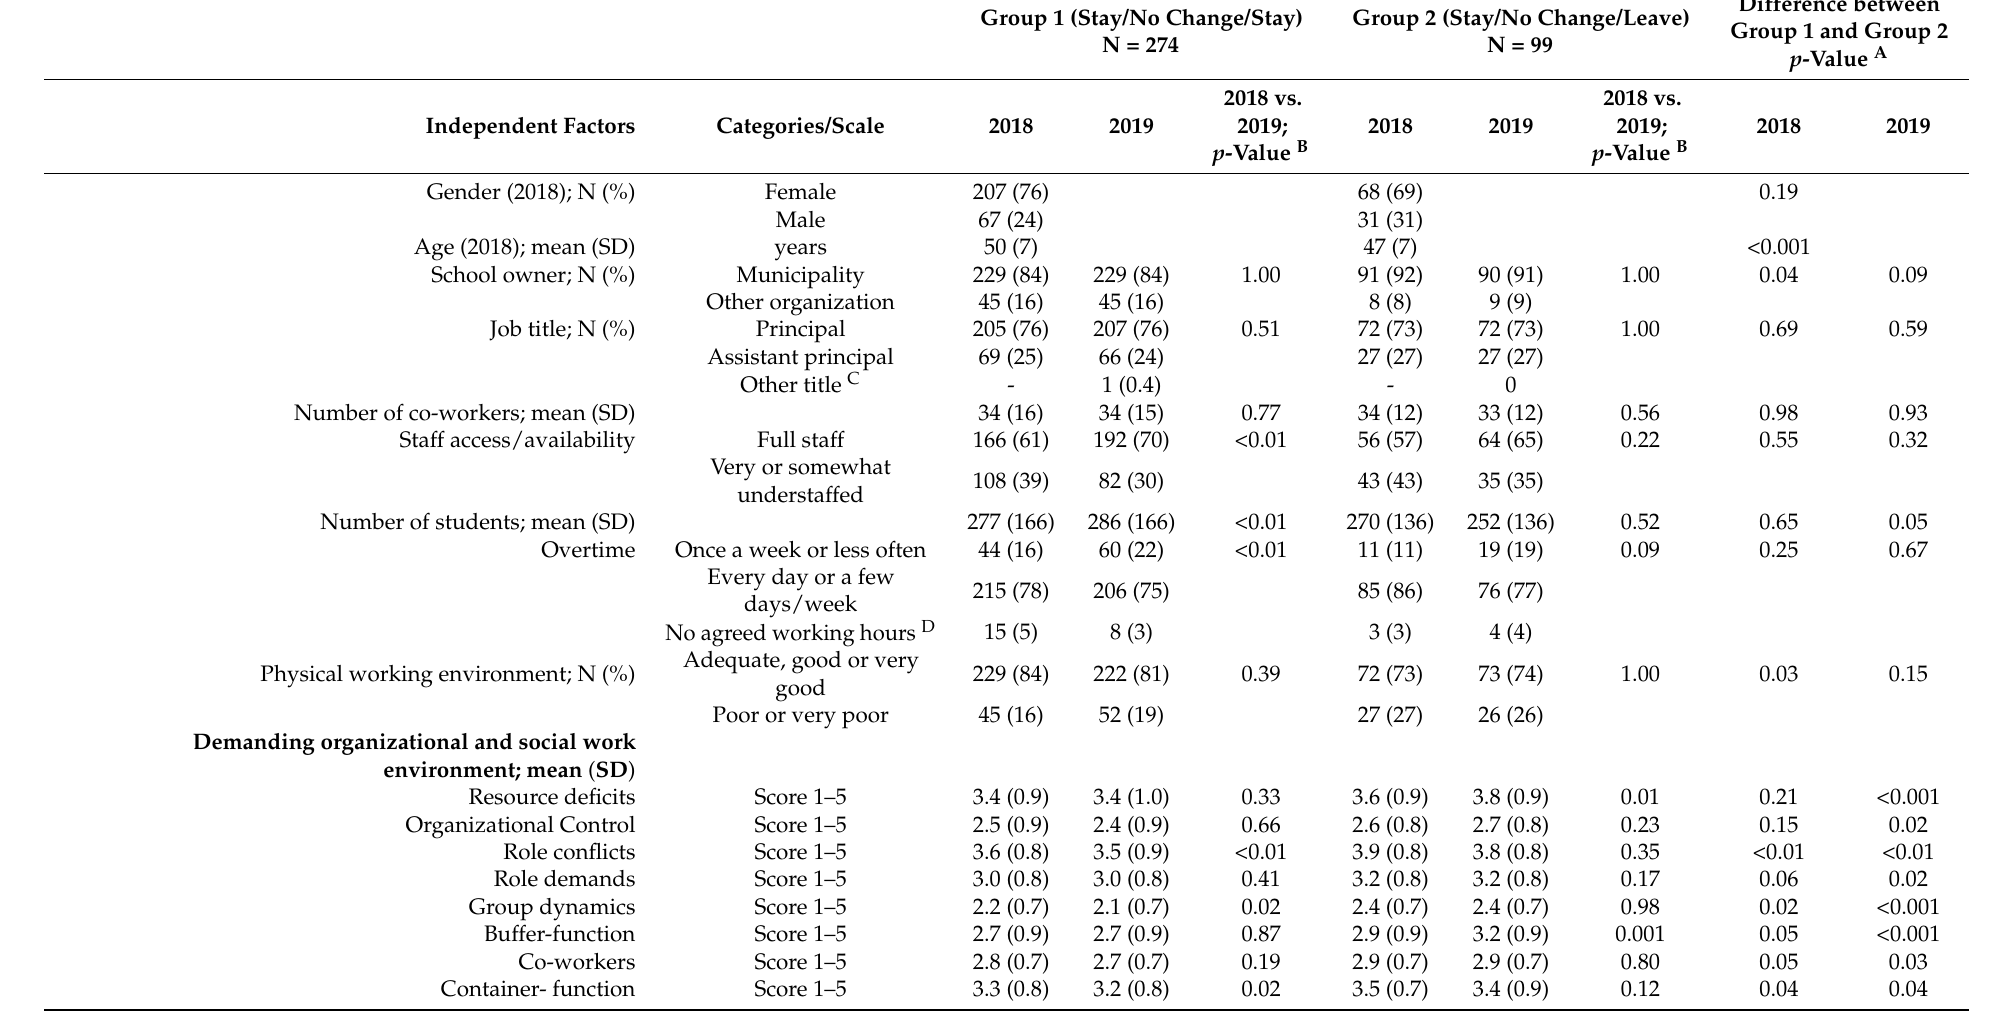
Table 3. Changes of reported exposures (2018 vs. 2019) within Group 1 (Stay/No change/Stay) and within Group 2 (Stay/No change/Leave) (Figure 1); and comparison of exposures between Group 1 and Group